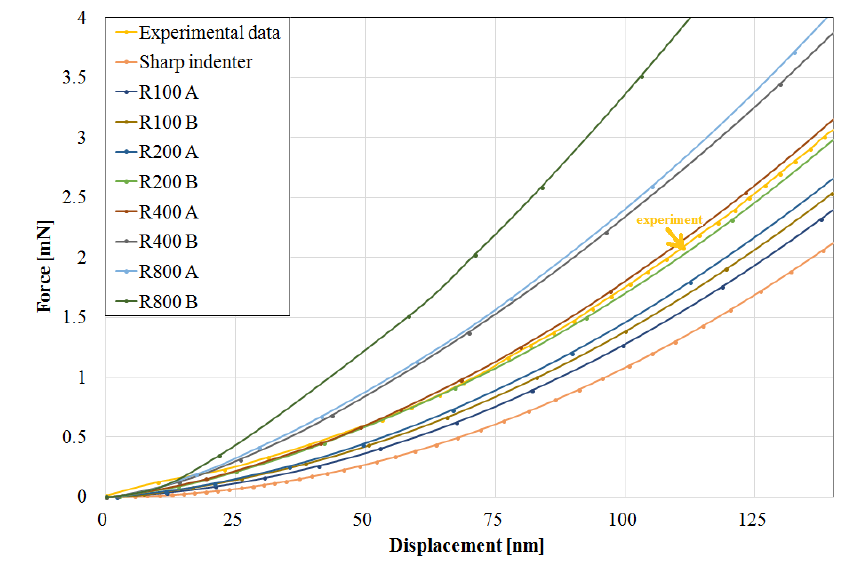
Figure 6. Indentation curves in the area of small displacements (detail of the Fig.